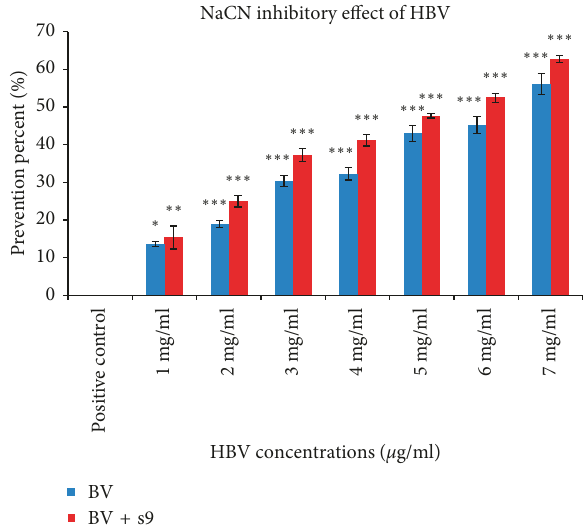
Figure 4: Sodium azide inhibitory effect of HBV in comparison with the positive control group with and without S9 fraction by the Ames test. S9 fraction promoted the prevention effect in a dose- dependent manner (mean ± SEM, ∗∗∗ p < 0 . 001, ∗∗ p < 0 . 01, ∗ p < 0 .